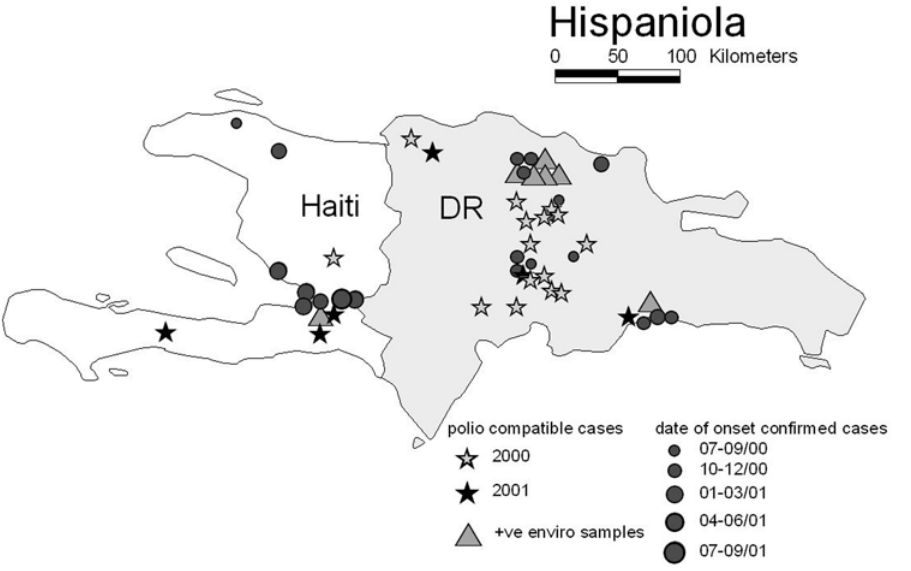
Figure 1. Geographic distribution of virologically-confirmed cases (represented by grey circles) and polio compatible cases (represented by filled stars) associated with type 1 cVDPV outbreak in Hispaniola between July 2000 and July 2001. Environmental samples that were positive for type 1 cVDPV isolates are represented by light grey triangles.